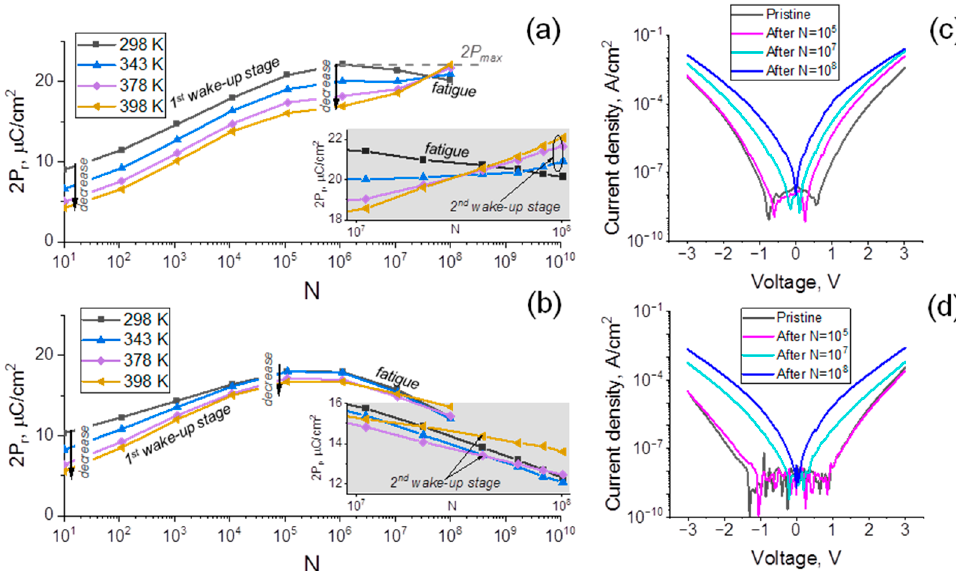
Figure 3. 2P r as a function of the number of switching cycles measured from devices with TiN ( a ) and Ru ( b ) TE at T amb ranging from 298 K (RT) to 398 K. Insets: enlarged 2P r (N) dependences at the N ranging from 10 7 to 10 8 . The measurements were performed using 3 µ s, 3 MV/cm pulses. ( c , d ) Leakage current densities measured from devices with TiN ( c ) and Ru ( d ) TE at